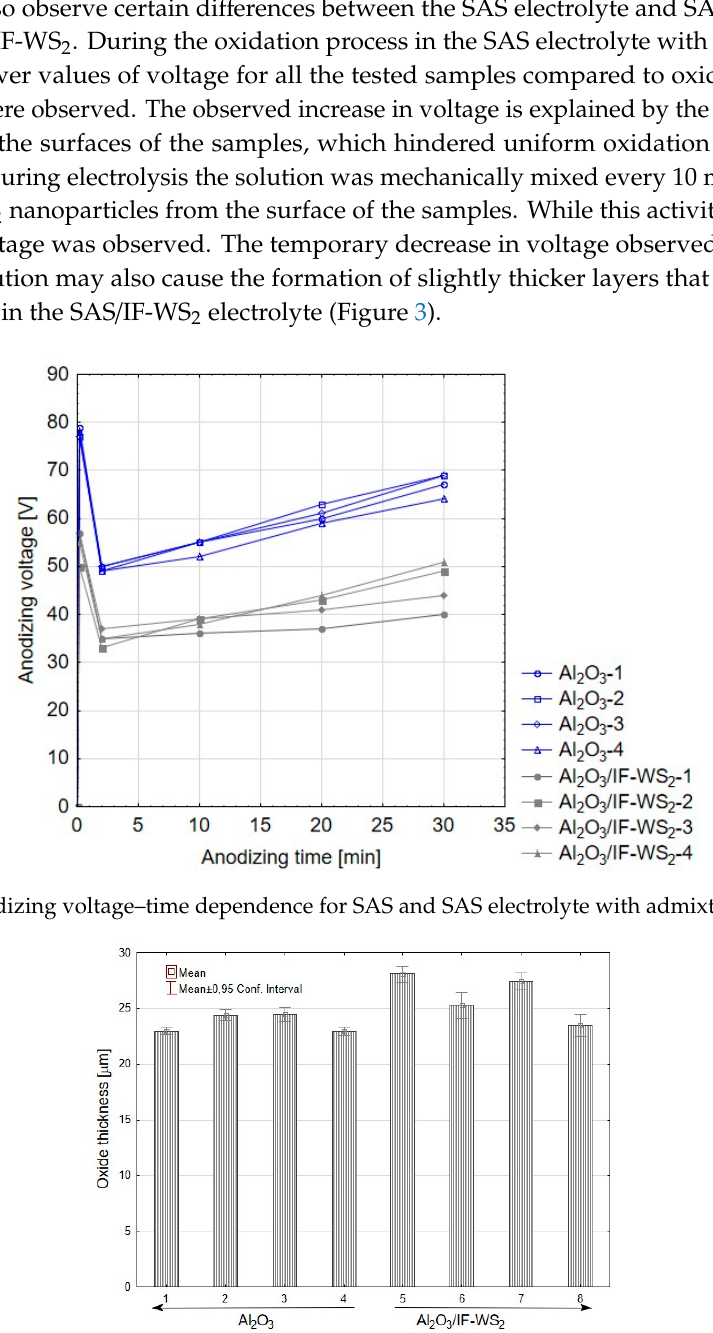
Figure 3. Thickness of the oxide layer on aluminium samples obtained in SAS and the SAS/IF-WS 2